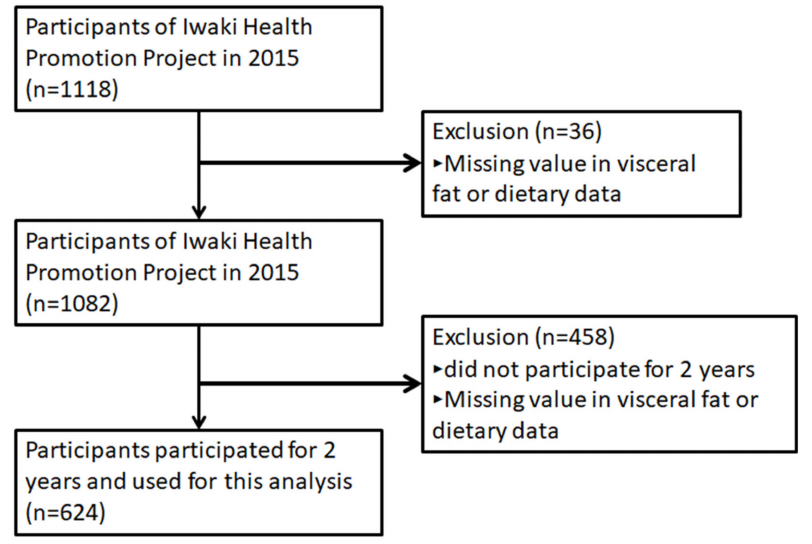
Figure 1. Study flow of the participants. A total of 624 participants completed measurements at the 3 time-points for 2 years (baseline in 2015, 2016, and 2017) among 1118 adults who participated in Iwaki Health Promotion Projects in 2015 (baseline) and were enrolled for the